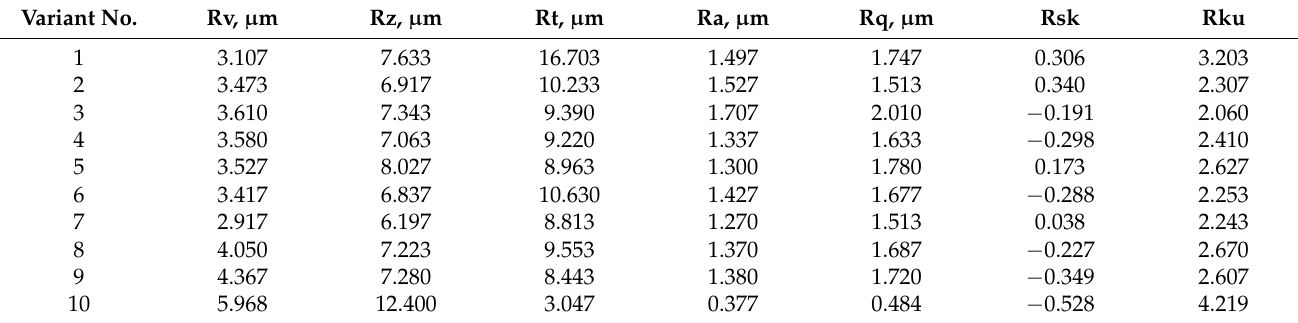
Table 7. Surface roughness parameters in the